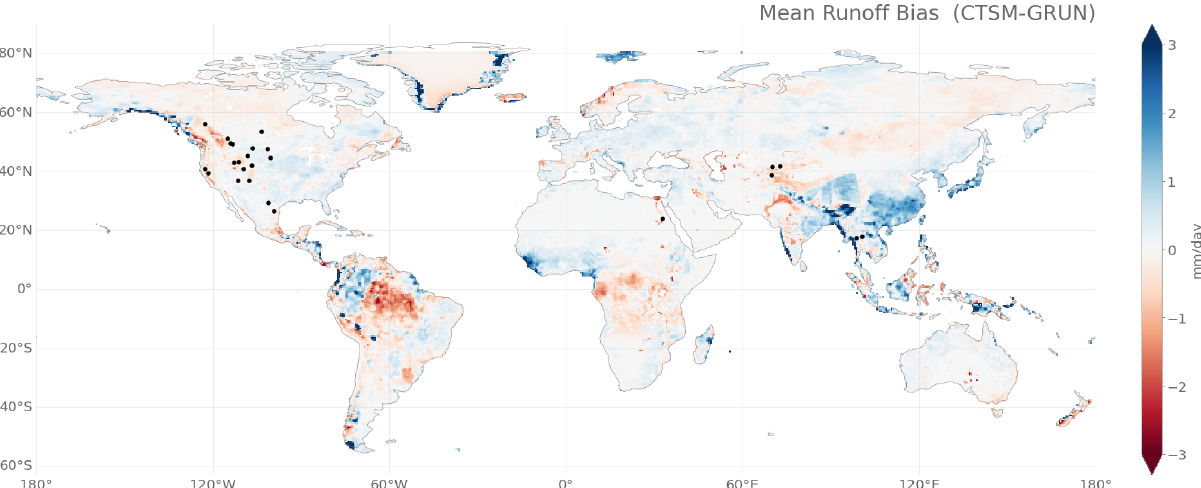
Figure 6. Mean runoff bias of CLM compared to G-RUN for the period 1971–2000. Black circles indicate the reservoirs used from the Yassin et al. (2019)